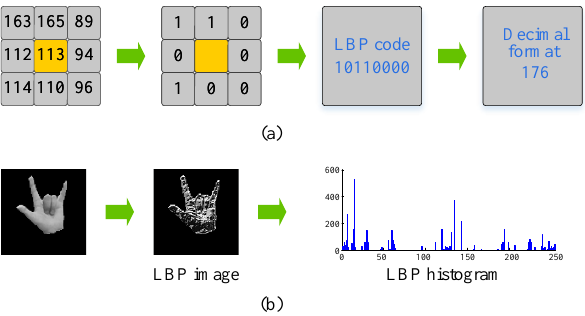
Figure 5. ( a ) Calculation of the LBP code. ( b ) Calculation of the LBP